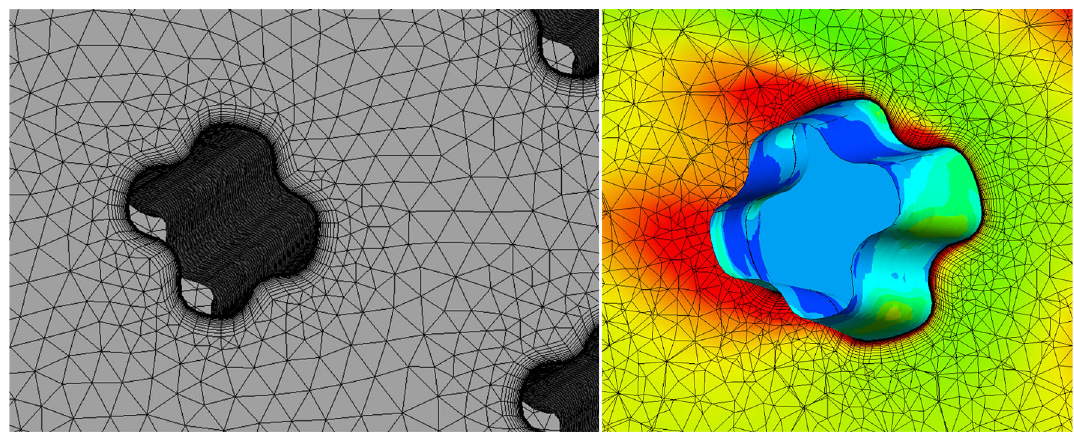
Fig. 3 Detail of numerical mesh near heat transfer surfaces with inflation